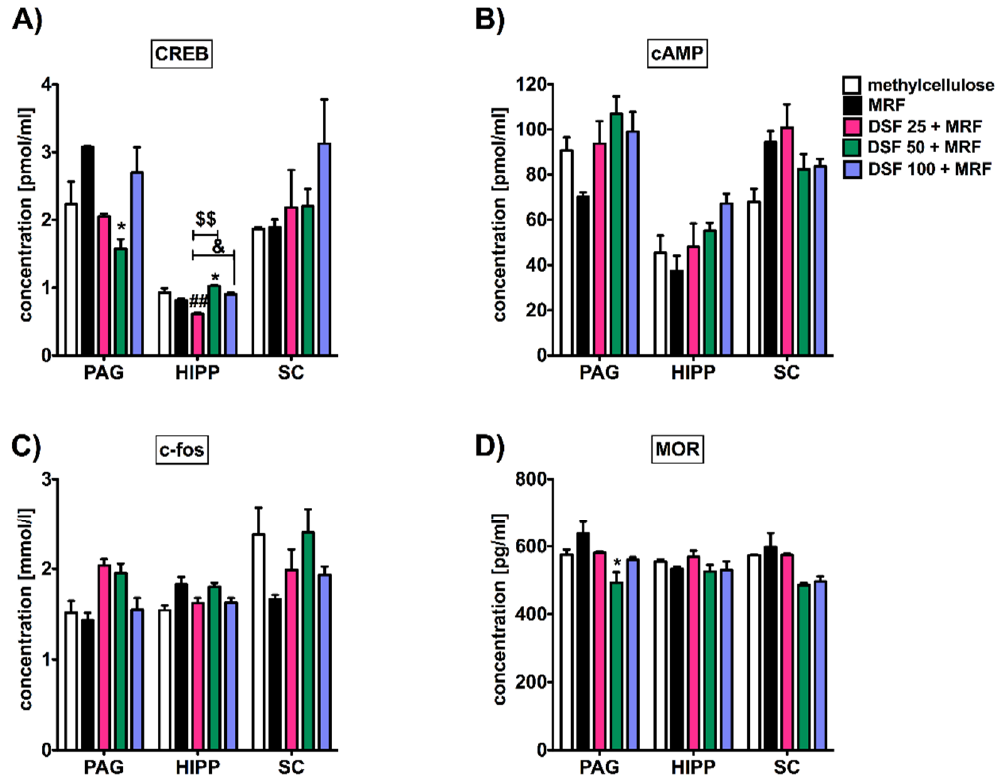
Figure 4. Changes observed in ( A ) CREB, ( B ) cAMP, ( C ) c-fos, and ( D ) mu-opioid receptor (MOR) levels in the brain and spinal cord tissues after DSF and MRF subacute intraperitoneal co-administration in comparison to morphine-treated rats by using the same paradigm. PAG, periaqueductal gray; HIPP, hippocampus; SC, spinal cord (spinal level); One-way ANOVA with Tukey’s post hoc test revealed differences in CREB levels in groups of: MRF vs. DSF 50 + MRF (* p < 0.05), methylcellulose vs. DSF 25 + MRF ( ## p < 0.01), DSF 25 + MRF vs. DSF 50 + MRF ( $$ p < 0.01), and DSF 25 + MRF vs. DSF 100 + MRF ( & p < 0.05), respectively. Additionally, a significant difference (* p < 0.05) was shown in mu-opioid receptor concentration in the PAG region between MRF and DSF 50 + MRF; n = 9 or 10 animals (male Wistar rats)/group.